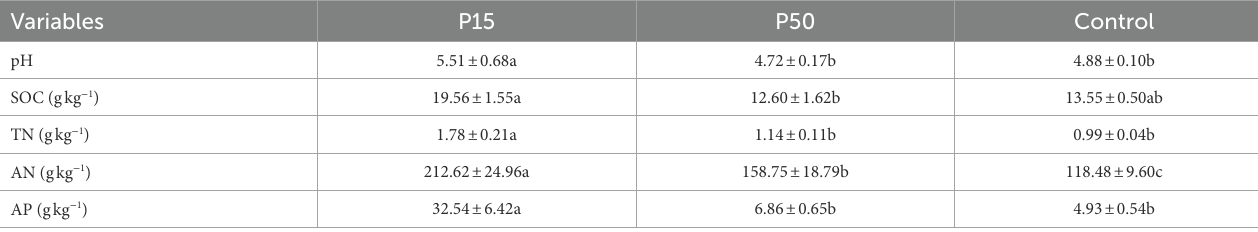
TABLE 1 Soil fertility in the Cinnamomum camphora coppice planting. Variables